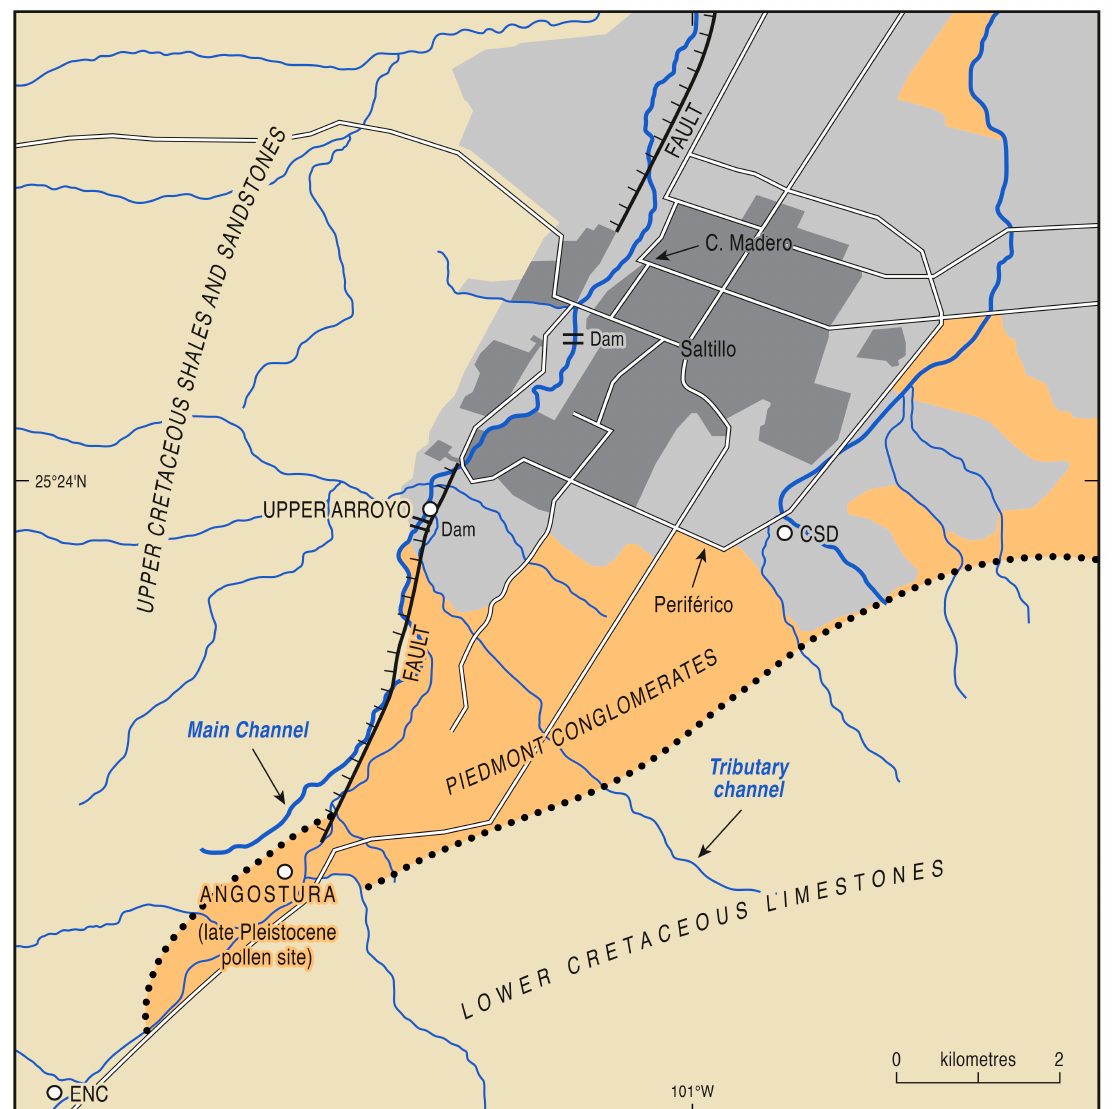
Figure 2. Saltillo region, southern Coahuila, Upper Arroyo site, with the main and tributary drainages indicated (modified from [13]).